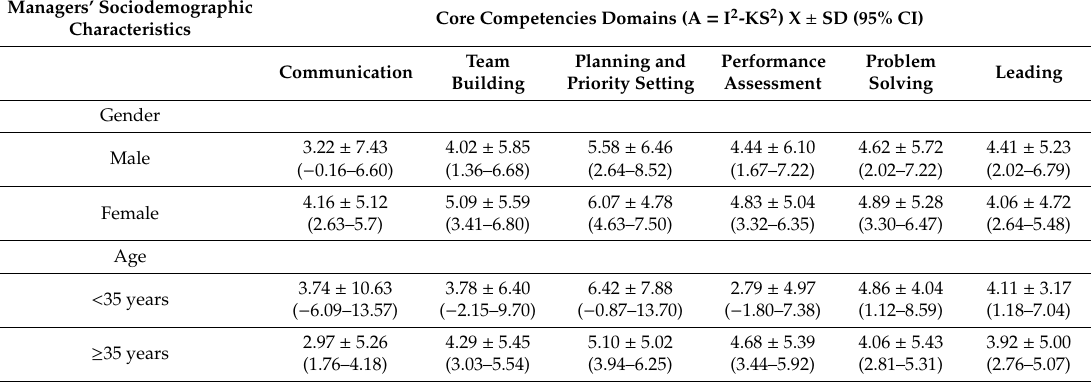
Table 3. Di ff erences in the perceived importance of knowledge and skills and self-perceived knowledge and skills by sociodemographic characteristics of managers in studied primary health care